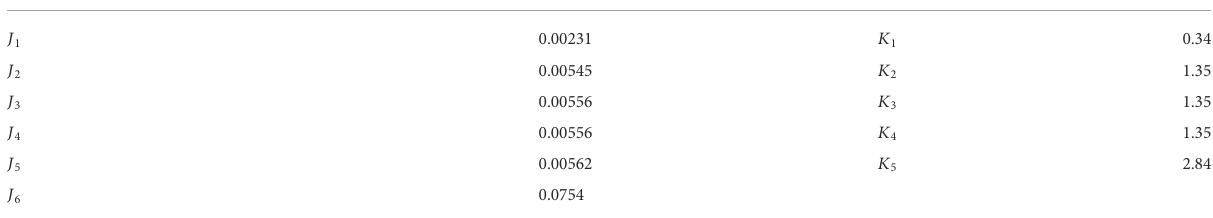
TABLE 1 Main parameters of the crankshaft system. Rotational inertia ( kg . m 2 )